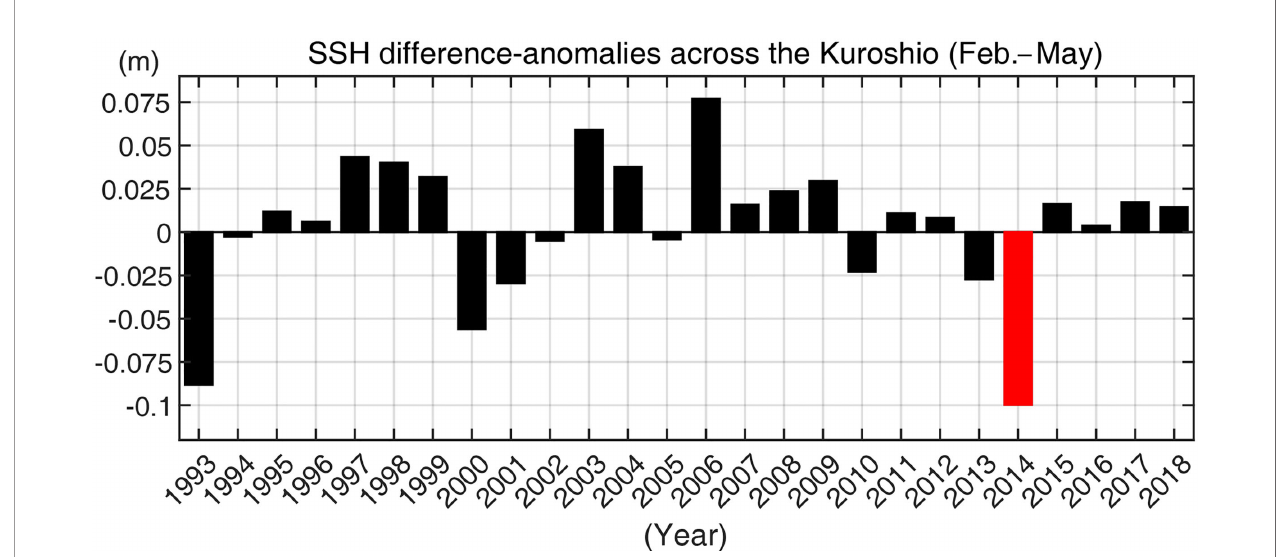
FIGURE 7 | Anomalies in climatological SSH gradients averaged over February – May from 1993 to 2018 in the Kuroshio upstream indicated by red line in Figure 1 . Note that the SSH gradient in the Kuroshio for 26 years is estimated with the two-satellite ADT product from